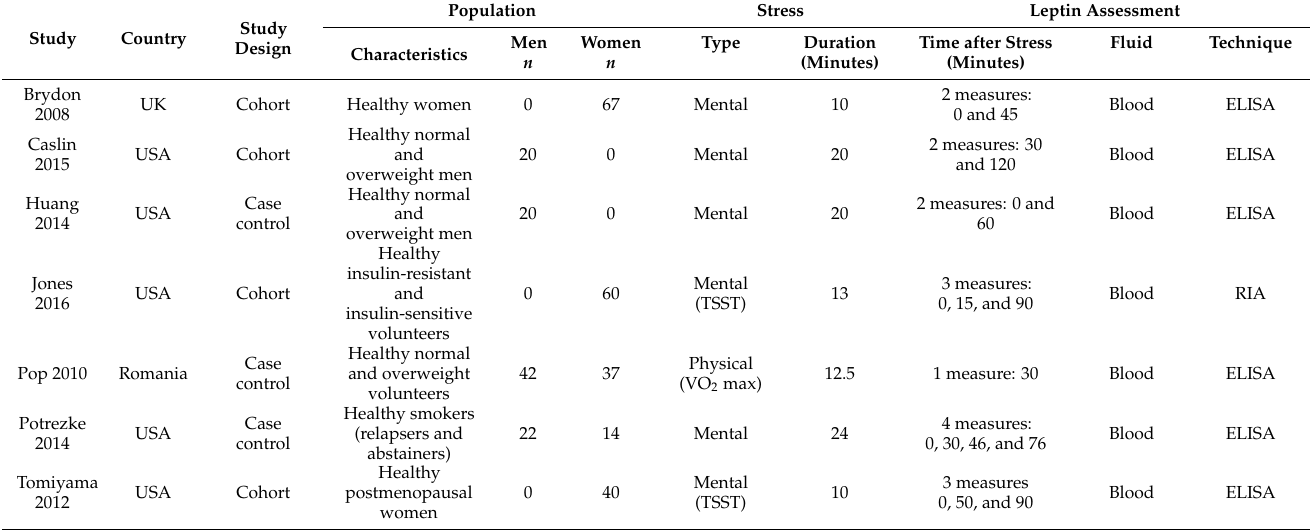
Table 1. Characteristics of included